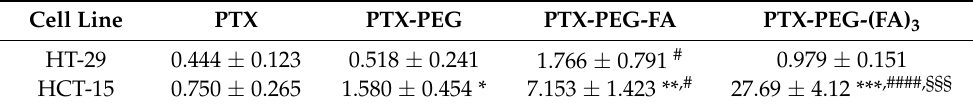
Figure 3. Cytotoxicity of PTX and PTX conjugates in FR-positive (HT-29) and FR-negative (HCT-15) cells. The results are the mean of three independent experiments, each performed in triplicate.